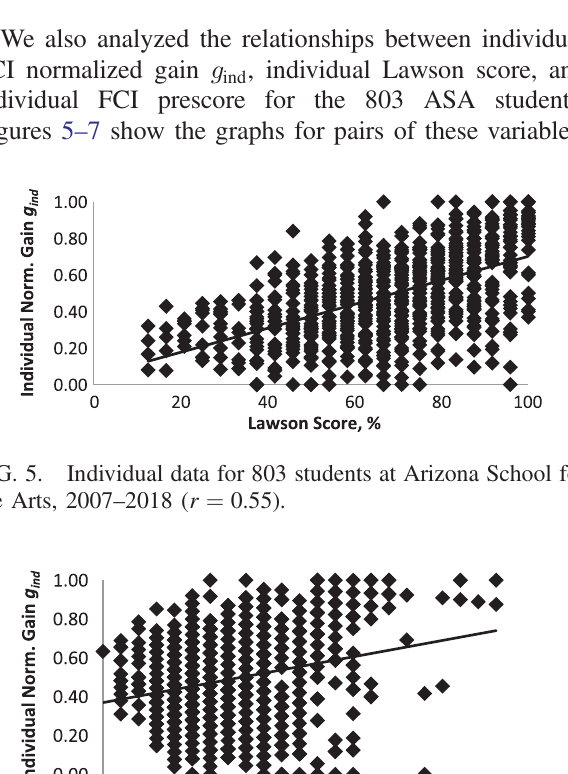
FIG. 4. Class average data for 36 classes at Arizona School for the Arts, with a total of 803 students ( r ¼ 0 . 00 ).